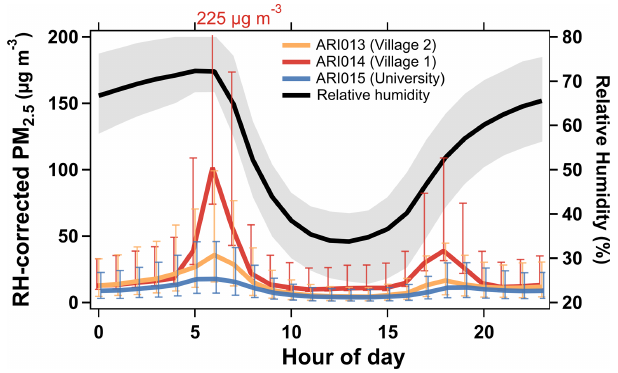
Figure 7. Diurnal trends of the integrated mean PM 2 . 5 mass con- centration measured by the OPC-N2 in each ARISense at each de- ployment site (left axis) and the annual relative humidity at the Vil- lage 2 site (right axis). Error bars represent the calculated 1 σ (68%) prediction interval of the hourly mean value. The red text annota- tion indicates the upper limit of the Village 1 prediction interval at 06:00LT (beyond the range of shown y axis). For RH data, the thick line indicates hourly mean, and the shaded region indicates interquartile